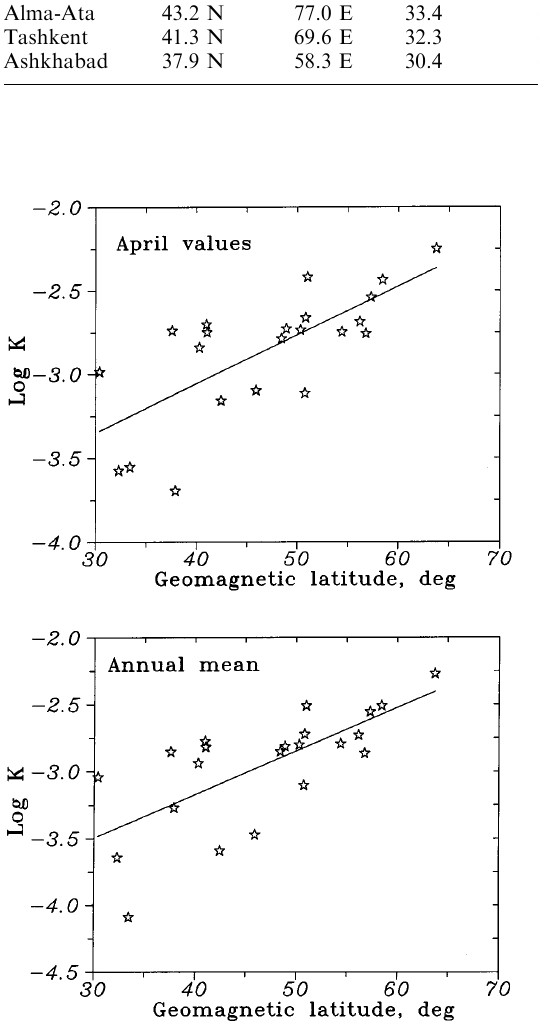
Fig. 2. The April ( top box ) and annual mean ( bottom ) log k values versus geomagnetic